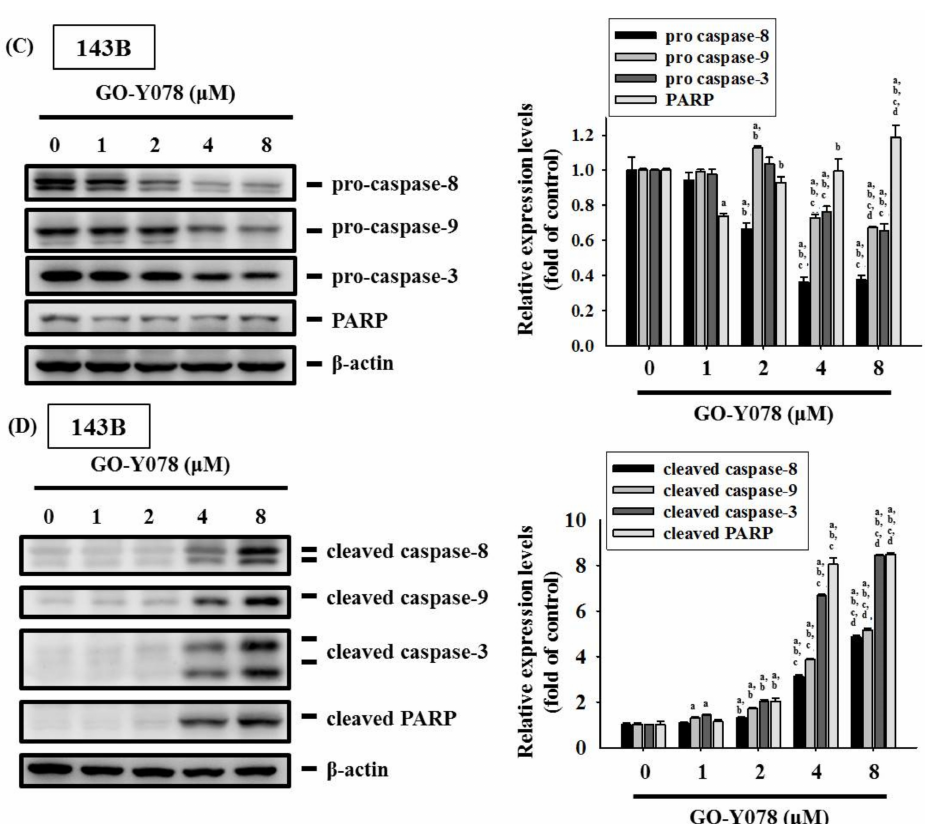
Figure 5. Effects of GO-Y078 on the activation of caspases 8, 9, and 3 in U2OS and 143B cells. Western blot analysis for ( A ) caspases 8, 9, and 3, and PARP as well as ( B ) their active forms after various concentrations (1, 2, 4, and 8 µ M) of GO-Y078 treatment for 24 h in U2OS and ( C , D ) 143B cells were measured; subsequently, all of them were subjected to quantitative analysis.